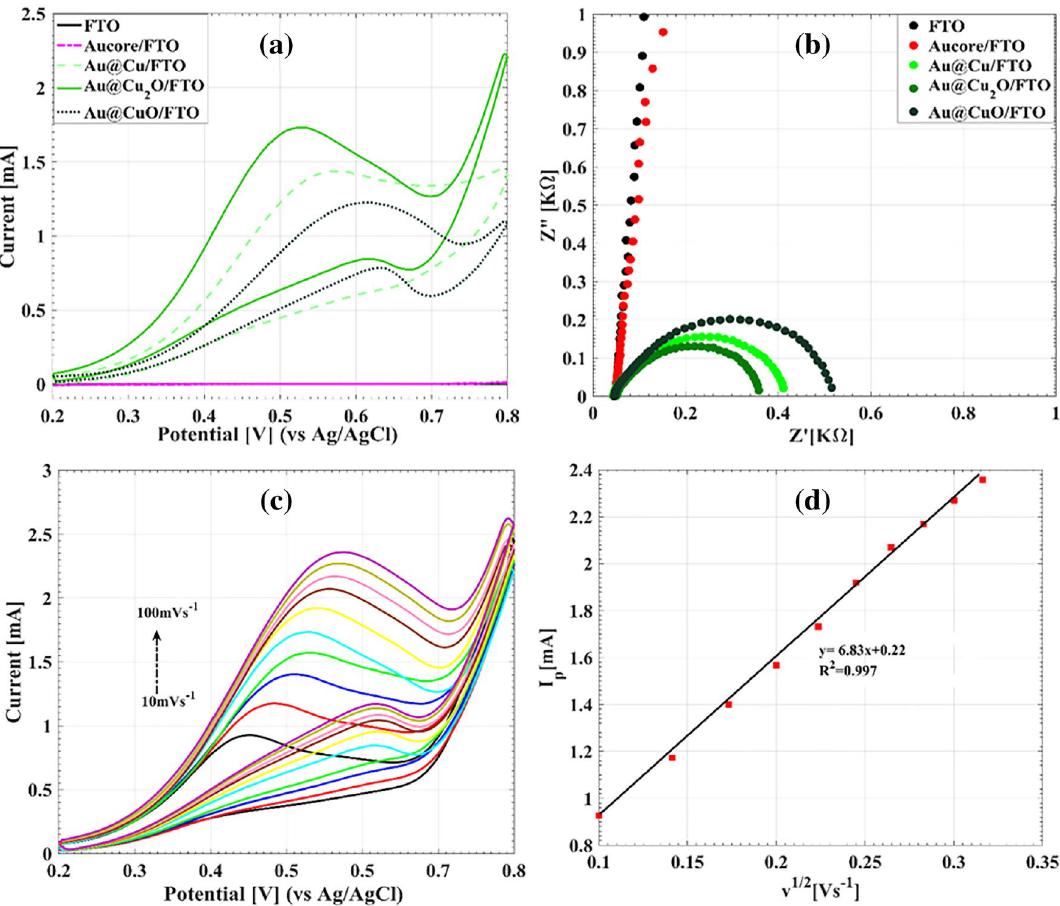
Figure 5. ( a ) The CV curves of different electrodes in present of 1 mM glucose in 0.1 M NaOH solution at scan rate of 50 mVs −1 . ( b ) Nyquist plots of EIS spectra of different electrodes in the frequency range from 100 kHz to 0.1 Hz at the applied potential of 0.55 V. ( c ) The CV curves of the Au@Cu 2 O electrode at different scan rates in 0.1 M NaOH with 1 mM glucose. ( d ) Calibration curve of anodic peak currents versus the square root of the scan Figure 5c shows the effect of scan rate on the glucose oxidation efficiency of the Au@Cu 2 O electrode. The anodic current is considerably enhanced by increasing of the scan rate. The increment of the scan rate from 10 to 100 mVs −1 directs to the small shift of the peak potential from 0.45 to 0.57 V, indicating the rapid electron transfer of the electrode for glucose oxidation process. As indicated in Fig. 5d, the linear dependency of the peak current (I p ) versus the square root of scan rate confirms a diffusion-controlled process due to the rapid electron transfer through the Au@Cu 2 O electrode.